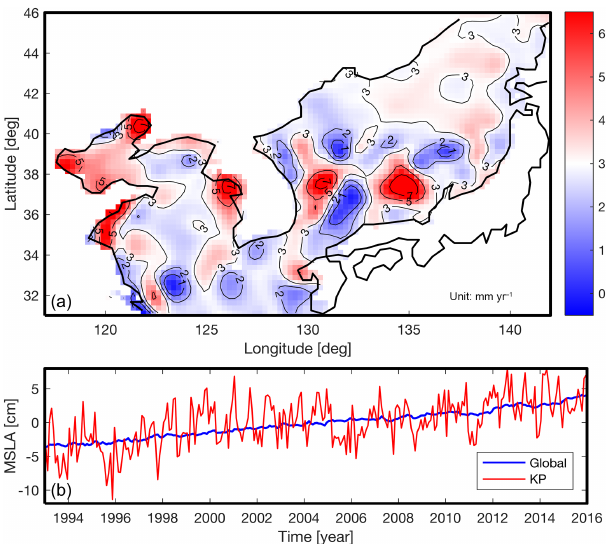
Figure 3. (a) Mean correlation coefficient map of sea level anoma- lies around the Korean Peninsula from AVISO without annual sig- nal from 1993 to 2015; (b) spatial mean time series of sea level anomalies from two regions of panel (a) where the red-colored area is the high-correlation coefficient zone and the blue-colored area is the low-correlation coefficient zone.